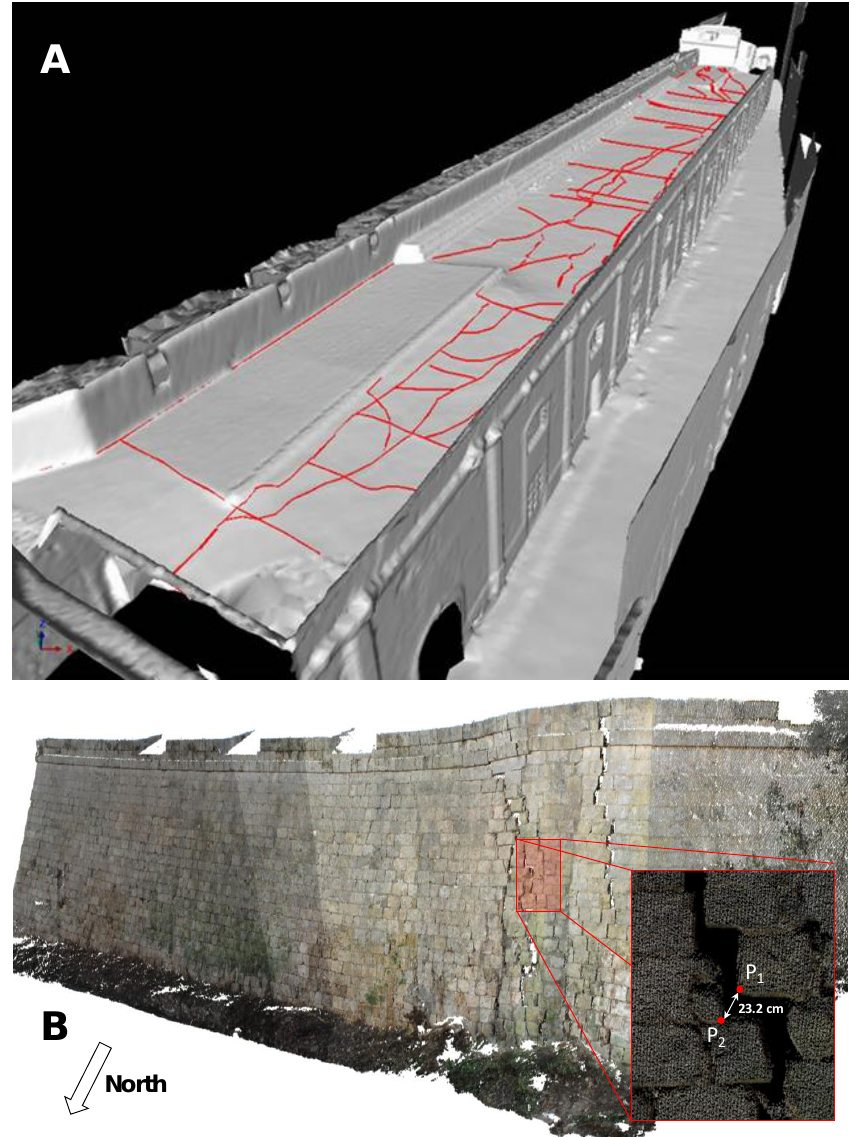
Fig. 11. (A) : 3-D polylines of the main cracks affecting the Curtain Magazines. (B) : True coloured point cloud and displacement vector of a crack affecting the Despuig Bastion (modified from Gigli et al.,